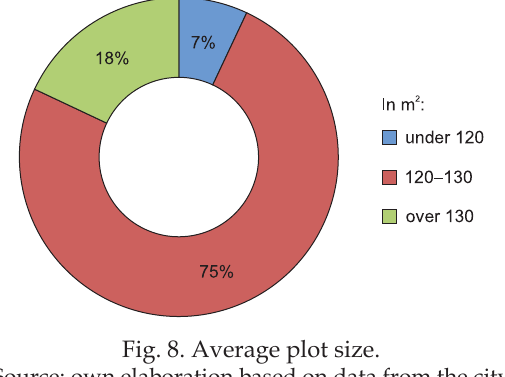
Fig. 8. Average plot